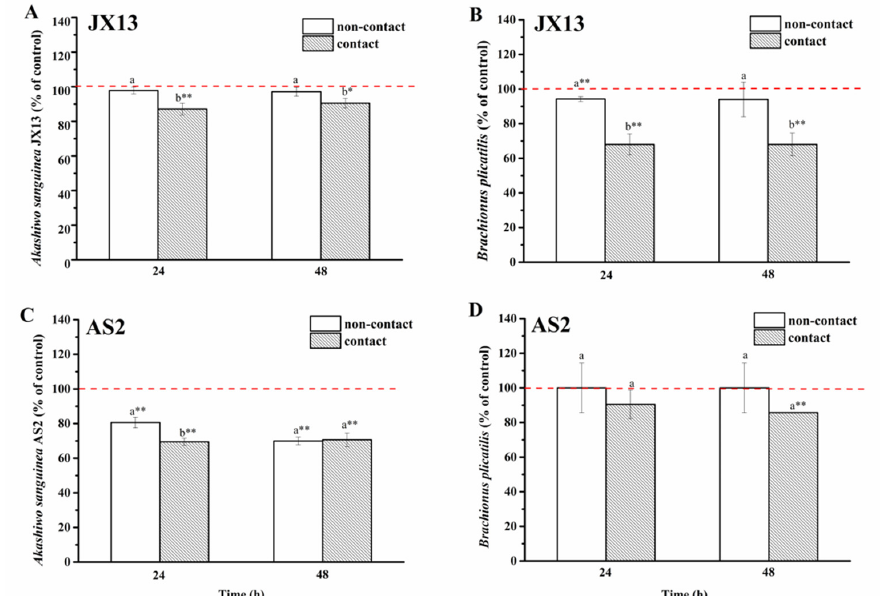
Figure 7. Contact and non-contact coculture of Akashiwo sanguinea (JX13, AS2) and Brachionus plicatilis . ( A , B ): A. sanguinea JX13 co-cultured with B. plicatilis ; ( C , D ): A. sanguinea AS2 co-cultured with B. plicatilis . Initial cell density of A. sanguinea was 8000 cells mL − 1 , and the initial number of B. plicatilis was 8 for each well. Results are expressed in triplicate ± standard deviation (SD). Different lower-case letters (a, b) indicate significant differences ( p < 0.05) between treatments at the same co-culture times; * and ** indicate significant differences ( p < 0.05 and p < 0.01, respectively) between treatment and control.